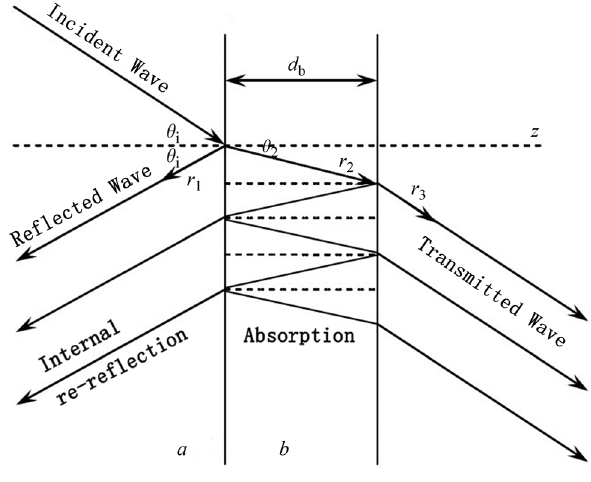
Figure 1: Schematic diagram of the electromagnetic wave propaga- tion in a single plate medium.